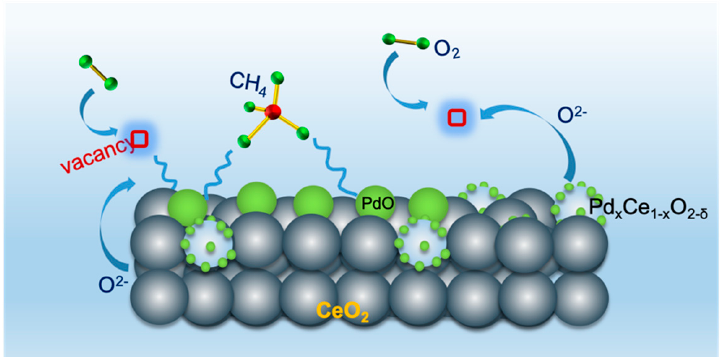
Figure 8. Schematic representation of the CH 4 oxidation over the Pd/CeO 2 catalyst.